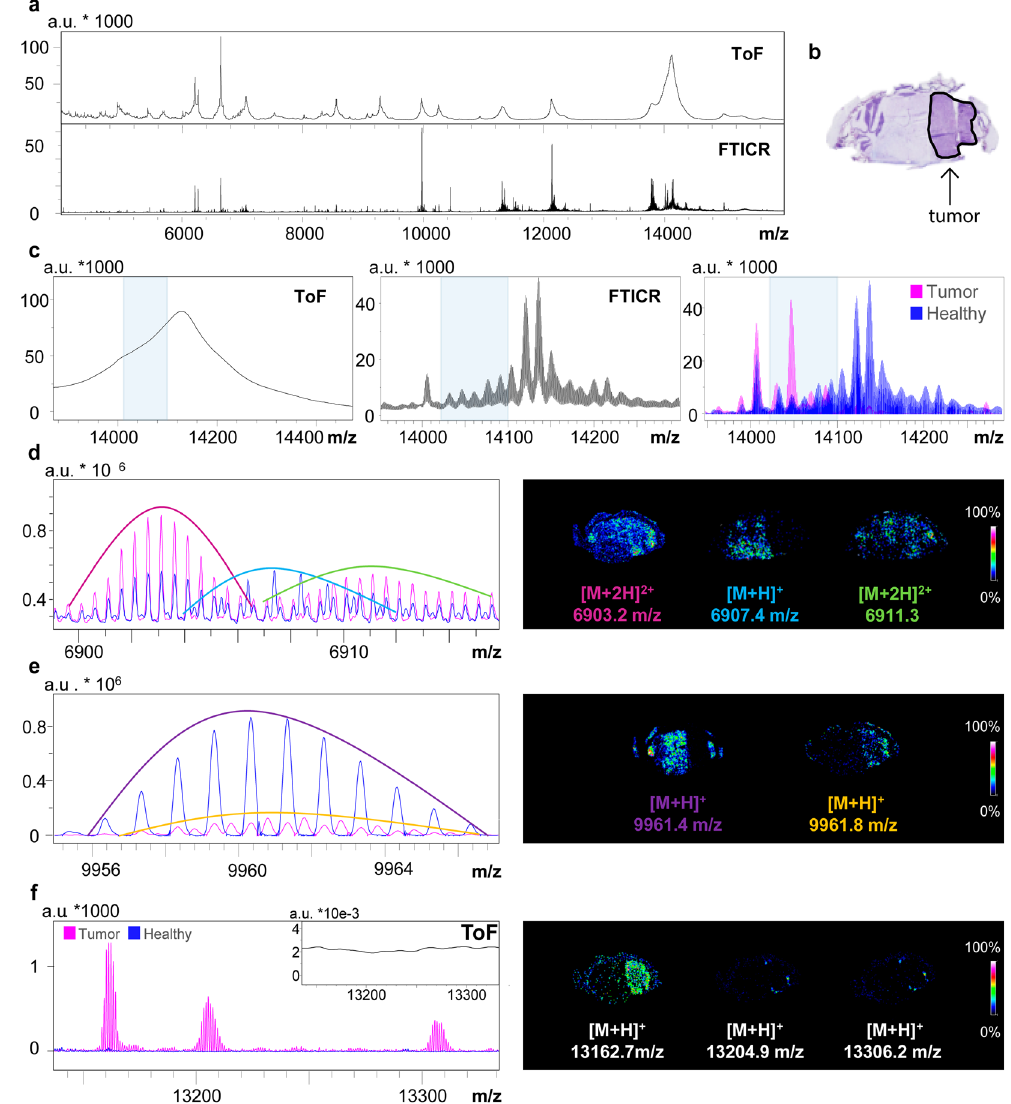
Figure 1. Insight into the complexity of the high mass resolution MSI data: ( a ) Comparison of the average mass spectra obtained from consecutive coronal mouse brain tissue sections with MALDI–ToF MSI and MALDI– FTICR MSI. ( b) Scanned image of the Nissl-stained mouse brain tissue, the solid black line highlights the tumor. ( c) From left to right: average MALDI TOF mass spectrum (left), average MALDI FTICR mass spectrum (center), and overlay of the average MALDI FTICR mass spectra from the tumor (pink) and healthy (blue) regions. The shaded region highlights tumor specific proteoforms that could only be revealed with the MALDI- FTICR. ( d) The ultra-high resolution of the MALDI-FTICR instrument distinguished two doubly charged proteoforms of Histone H2B and a different singly charged protein. ( e) MALDI-FTICR spectra showing the differentiation of two protein ions of similar mass with interspersed and isobaric isotopomers, and which have differential localization. ( f) Overlaid average mass spectra of tumor and healthy regions showing the specific distribution of three ions that could not be detected with MALDI-TOF MSI (MALDI-TOF mass spectrum shown in